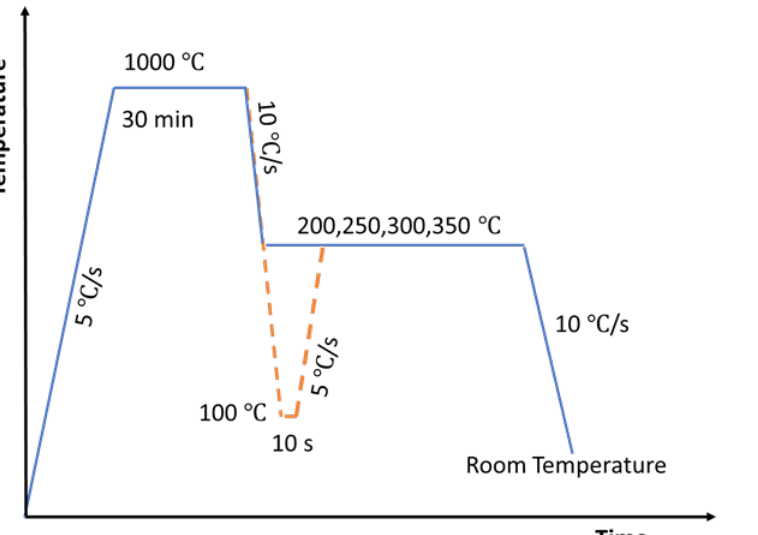
Figure 1. Schematic view of the different heat treatment schedules (temperature vs. time) used in this work.